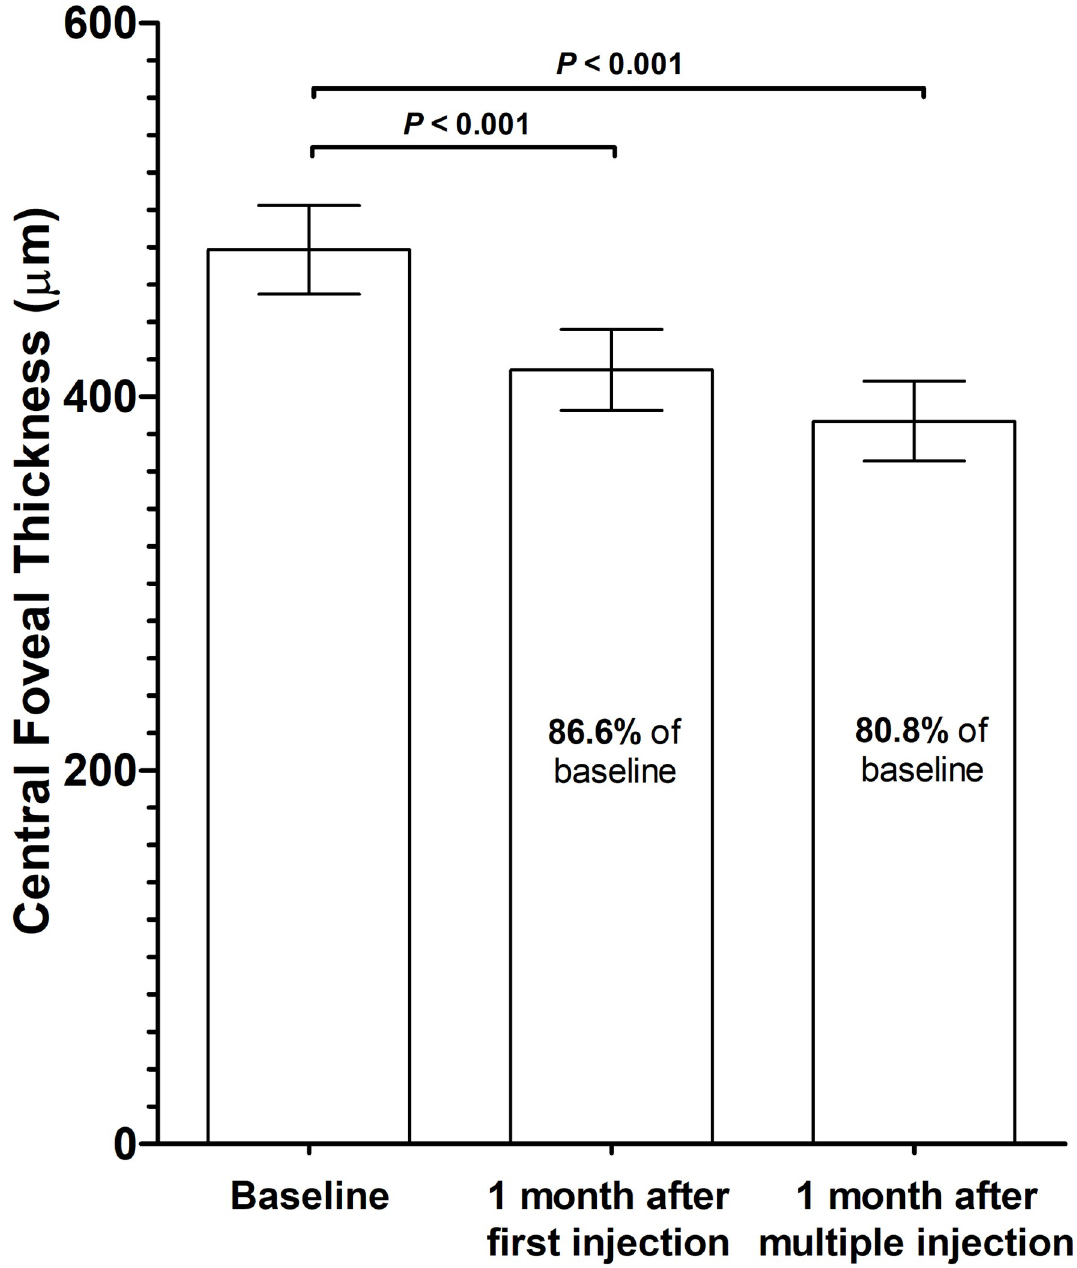
Fig 3. Change in central foveal thickness (CFT). The bars represent mean CFT and the error bars represent standard error of mean. multiple injections (P < 0.001); however, there was no significant change in BCVA (n = 26) after the first injection (P = 0.384) or monthly multiple injections (P = 0.423) (Table 5). Discussion Our study showed that intravitreal anti-VEGF injections in vitrectomized nAMD eyes decreased CFT and maintained BCVA.